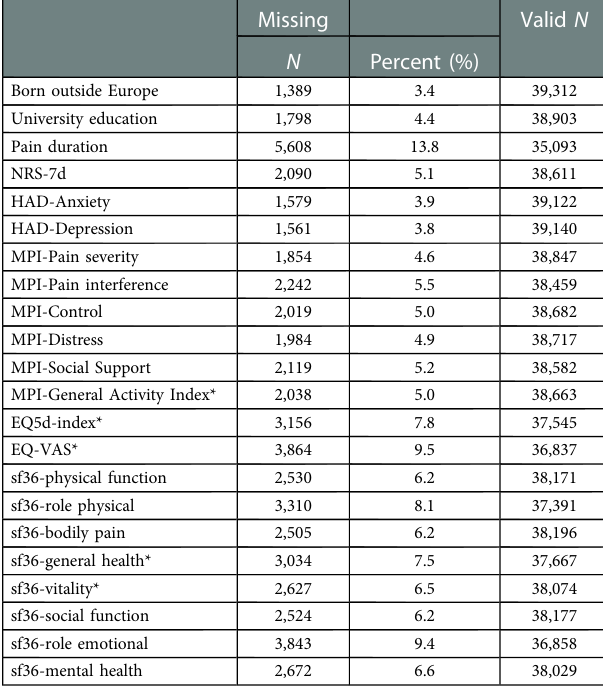
TABLE 1 Variables with missing data before imputation – baseline data. Gender, age, and PRI had no missing data. Note that some of these variables were not included in the subsequent analyses (see